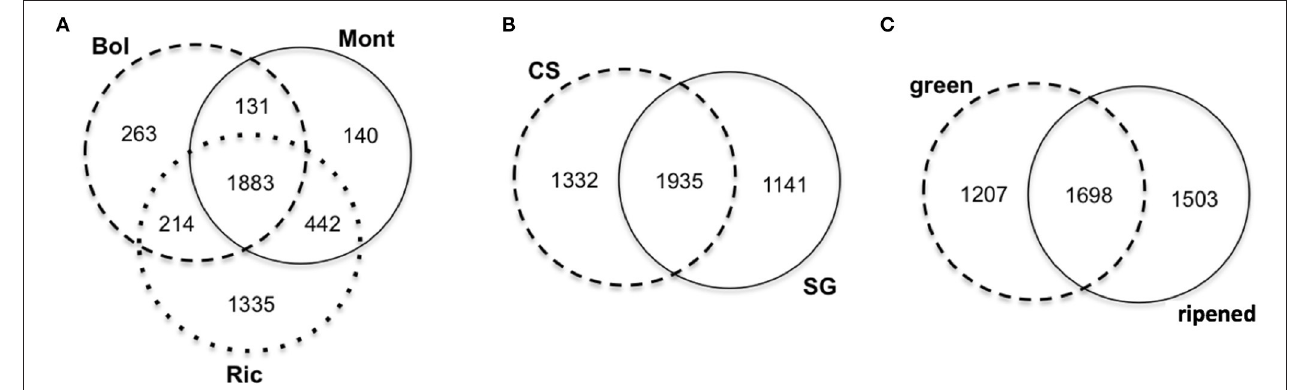
FIGURE 2 | Venn Diagrams comparing the sRNA-generating clusters of Vitis vinifera expressed by (A) environment, (B) cultivar, (C) developmental stage. Bol, Bolgheri; Mont, Montalcino; Ric, Riccione; CS, Cabernet Sauvignon; SG, Sangiovese. Green corresponds to bunch closure and ripened corresponds to 19 ◦ Brix developmental